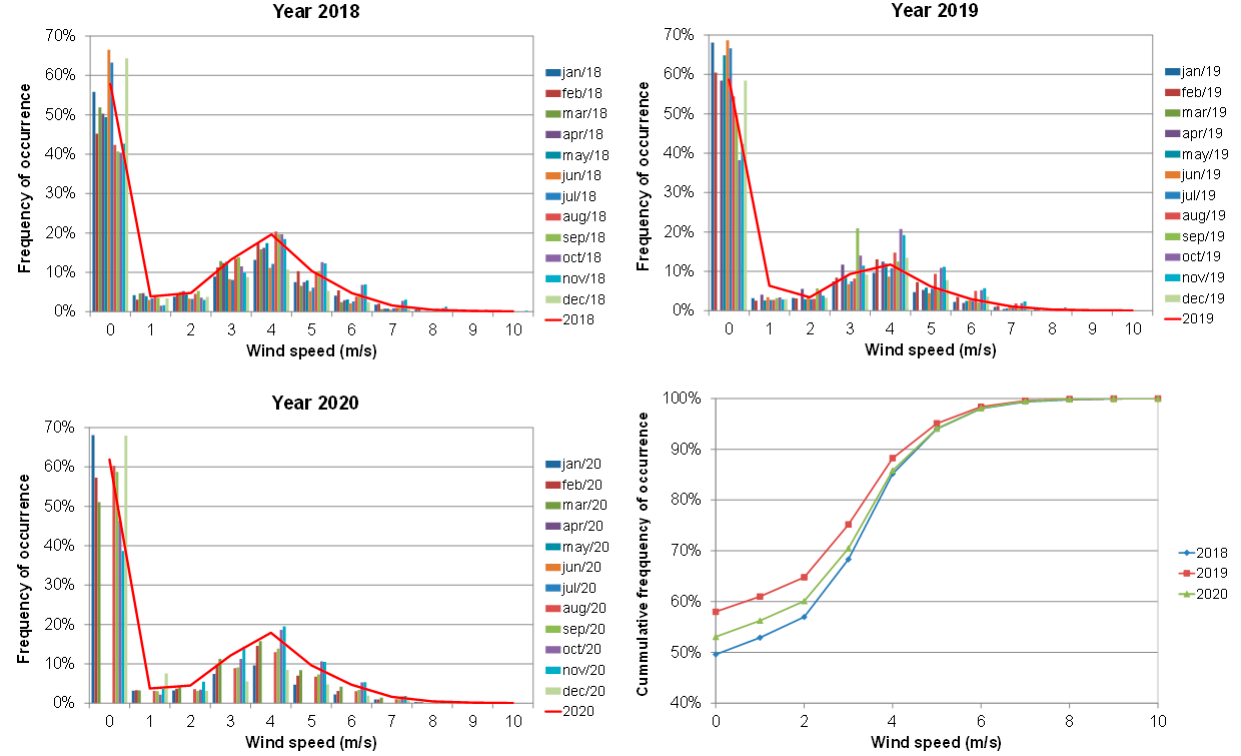
Figure 15. Wind speed frequency occurrence—measurements from turbine rotation speed data in the three years 2018 to 2020.